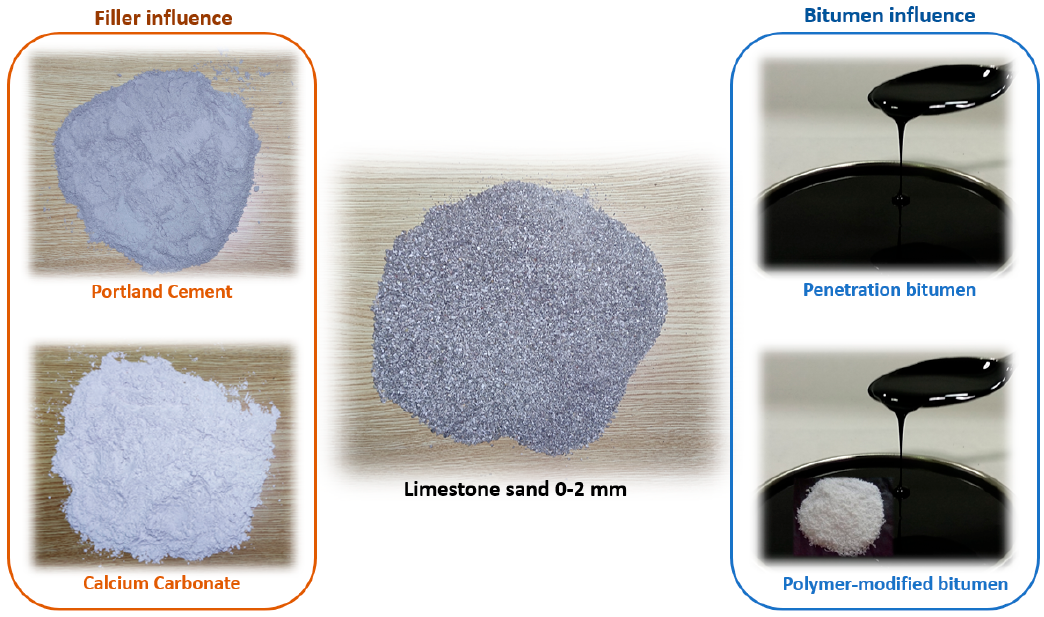
Figure 1. Components of the asphalt mortars studied.